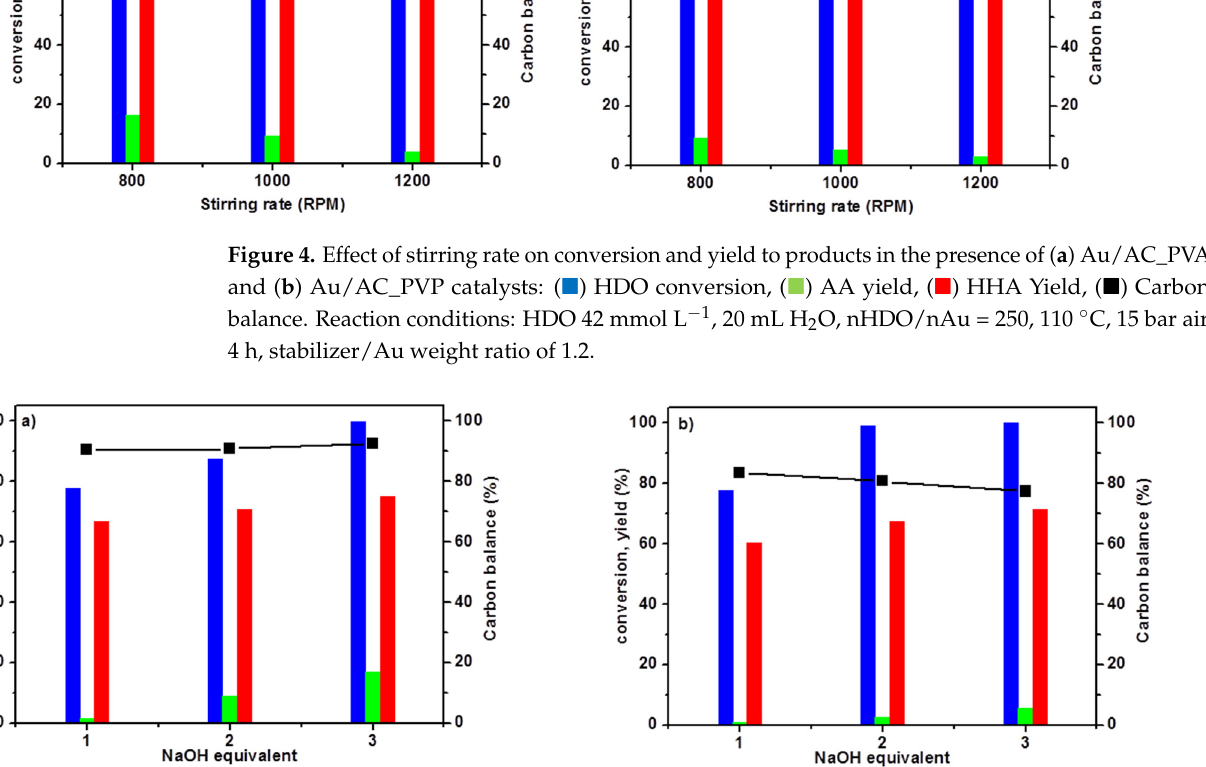
Figure 4. Effect of stirring rate on conversion and yield to products in the presence of ( a ) Au/AC_PVA and ( b ) Au/AC_PVP catalysts: ( ■ ) HDO conversion, ( ■ ) AA yield, ( ■ ) HHA Yield, ( ■ ) Carbon balance. Reaction conditions: HDO 42 mmol L − 1 , 20 mL H 2 O, nHDO/nAu =250, 110 °C, 15 bar air, 4 h, stabilizer/Au weight ratio of 1.2.